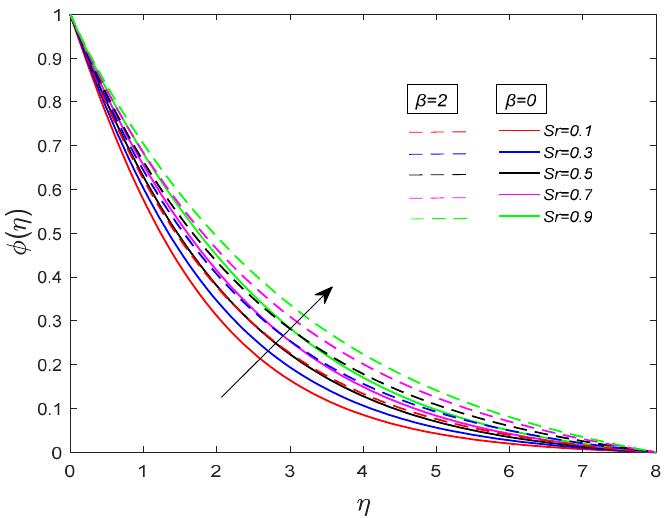
Figure 15. Effect of Soret parameter (Sr) on concentration profile with Pr = Sc = 0.7, M = 0.5, Ec = Kr = 0.1.